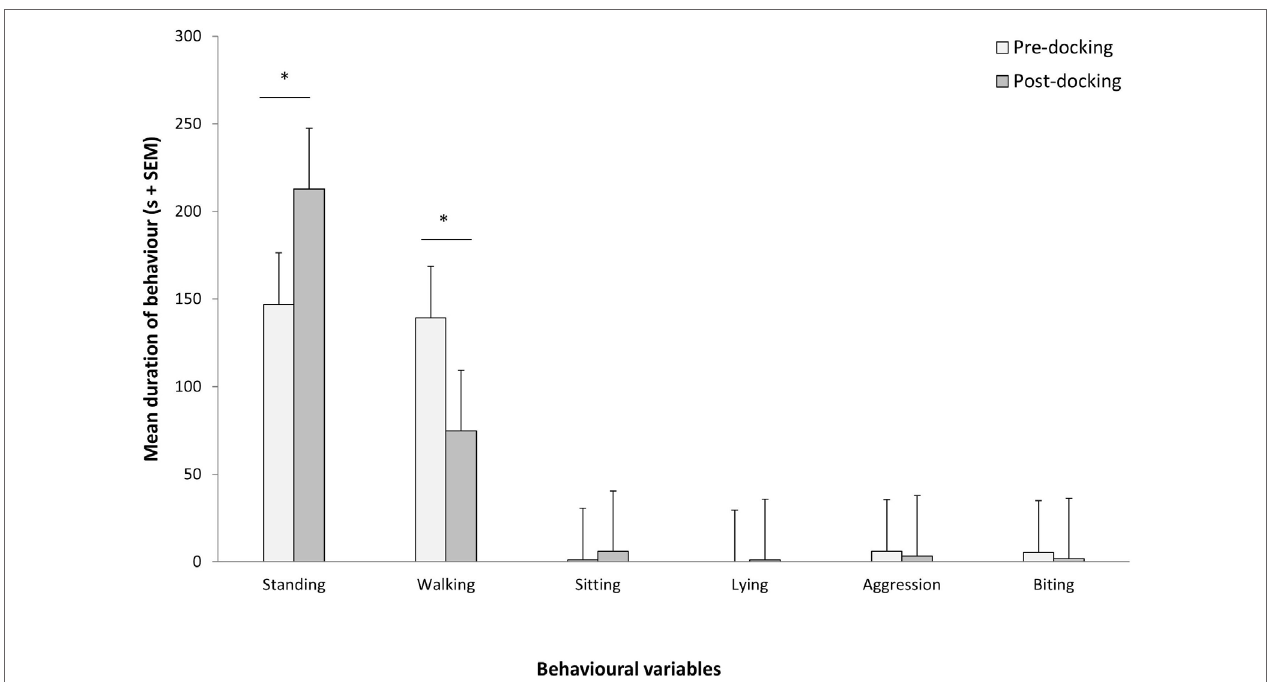
FigUre 5 | changes in pre vs. post-tail docking behaviors . Mean ( + SEM) duration of each behavior recorded for 5 min pre and immediately following tail docking. The asterisk denotes significant difference ( P <